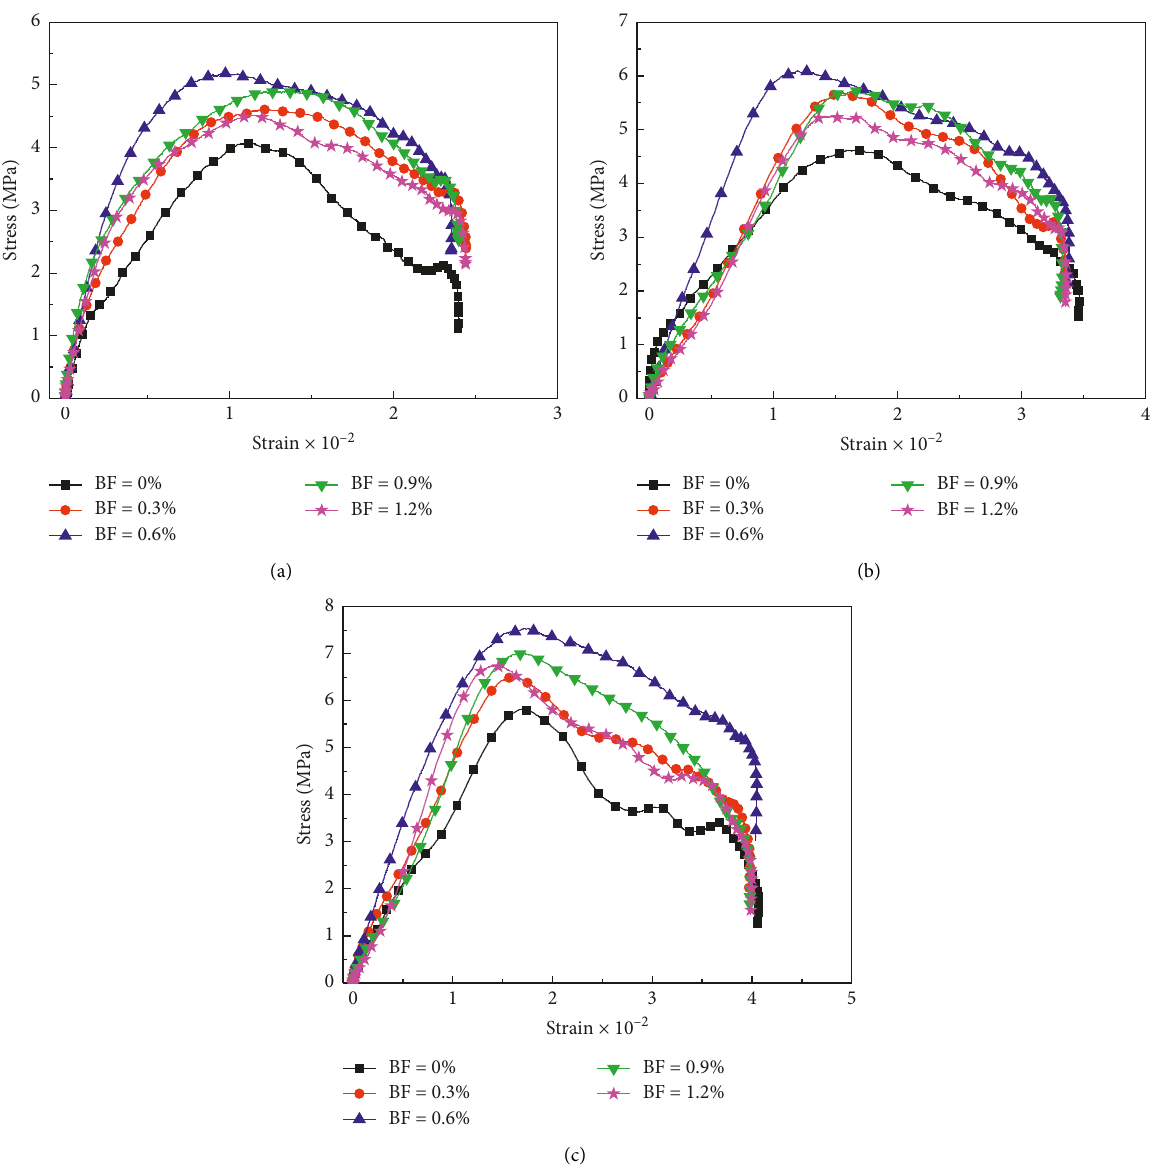
Figure 12: Dynamic stress-strain curves of basalt fiber-reinforced cement-fly ash-stabilized soil. (a) 0.3MPa impact loading pressure. (b) 0.4 MPa impact loading pressure. (c) 0.5MPa impact loading